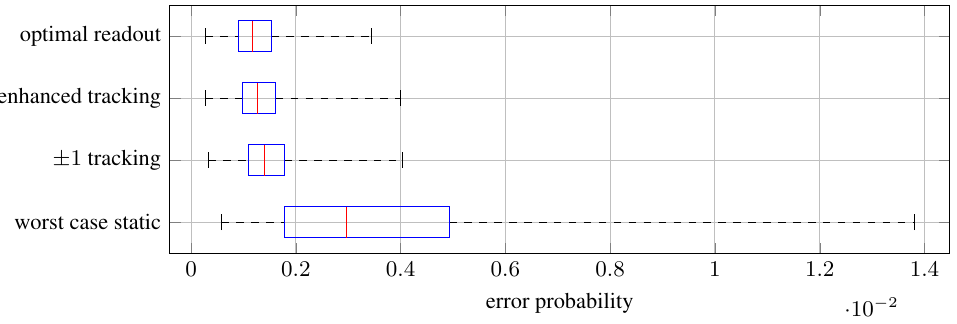
Figure 14. Error statistic on reference r 7 of all pages of 27 Blocks with 55 h bake 3000